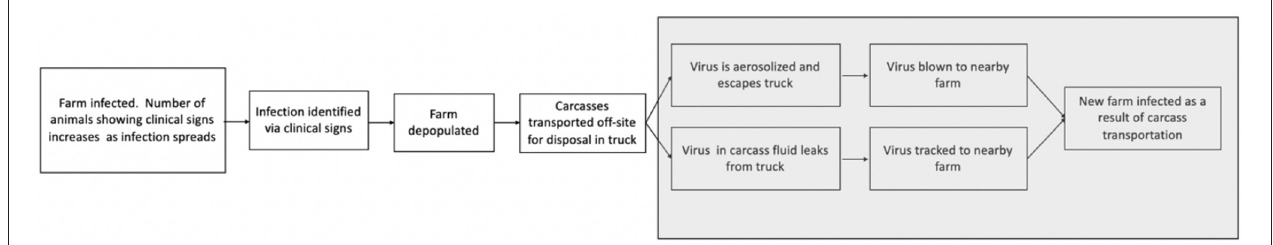
FIGURE 1 | Disease spread pathway by which FMDv may spread during the transportation of carcasses from an infected livestock premises to an off-site disposal location. Steps in gray represent the potential transmisson risks during transportation.